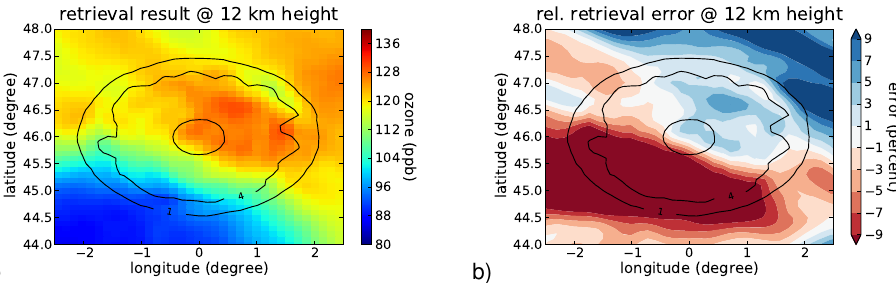
Fig. 15. The retrieval result of a run with advection and no compensation during the retrieval. Panel (a) shows the retrieved ozone values at 12 km height while panel (b) depicts the relative error in percent compared to the true values. The number of tangent points within the depicted volume elements is overlaid as a contour plot.